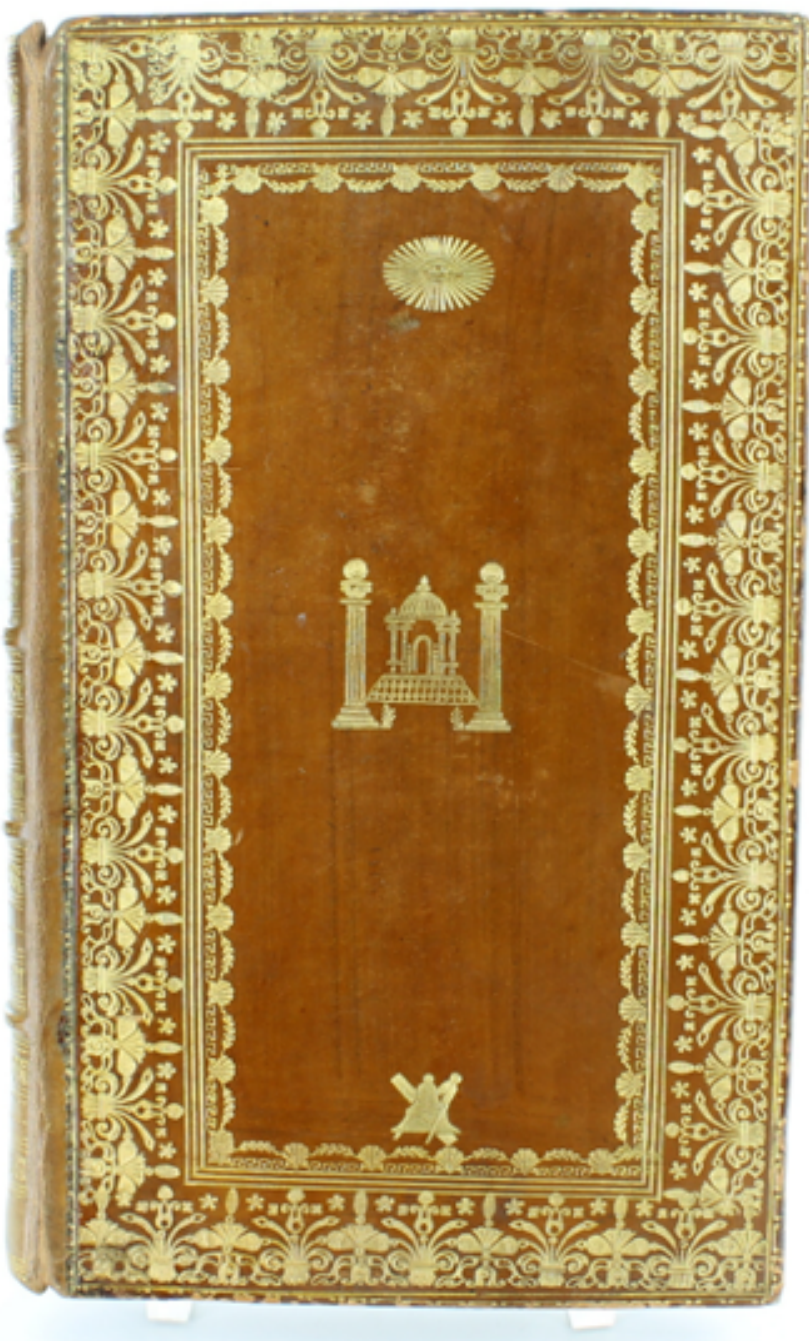
Fig. 45. Upper cover of Constitutions (Dublin, 1807). Copyright and reproduced by permission of the Museum of Freemasonry, London.